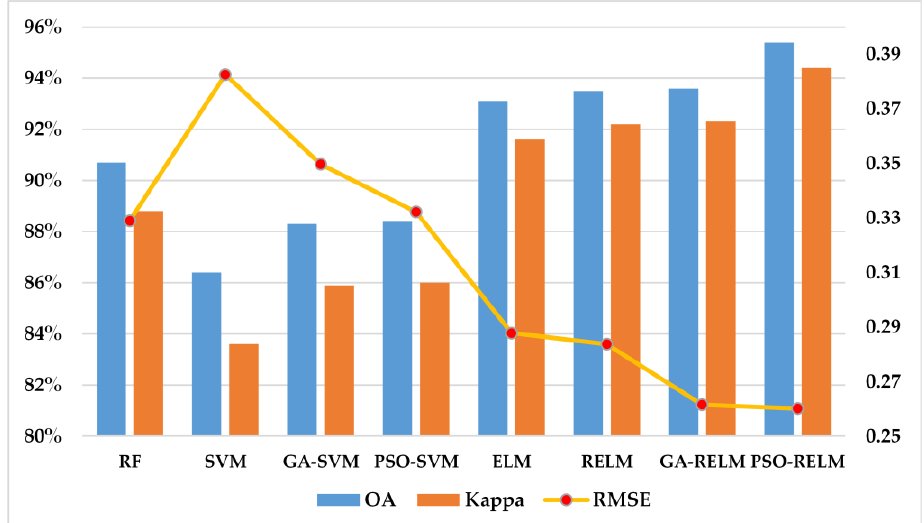
Figure 12. Overall evaluation metrics of the testing samples in the Z2 area.